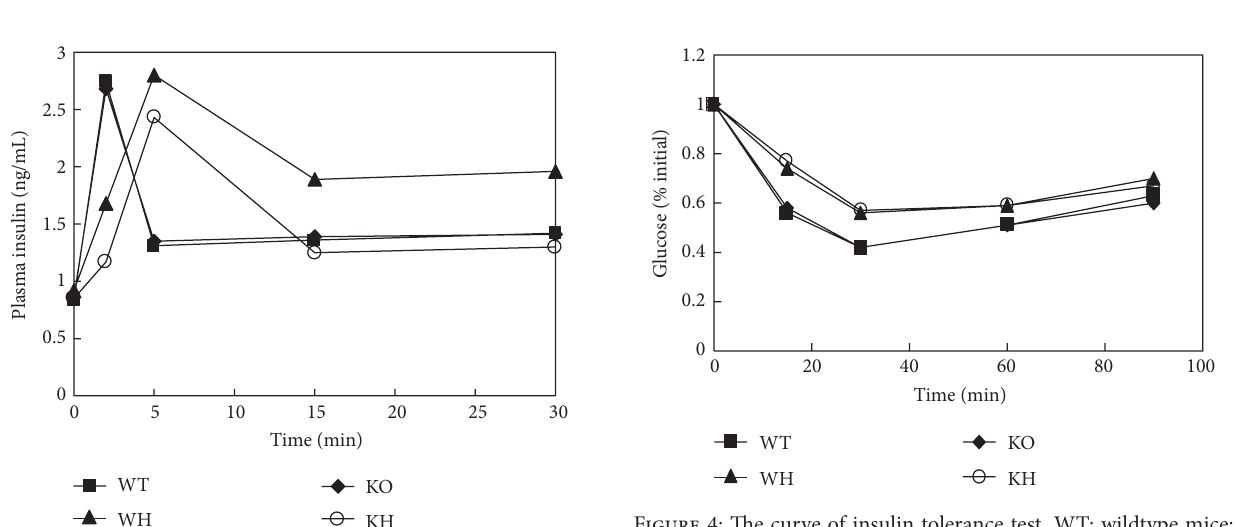
Figure 2: The curve of glucose tolerance test. (a) Glucose curve; (b) area under curve of glucose (AUCG). WT: wildtype mice; WH: wildtype mice with high-fat diet; KO: ACE2 knockout mice; KH: ACE2 KO mice with high-fat diet, versus WT ∗ 𝑃 < 0.05 , versus KO # 𝑃 < 0.05 , and versus WH 󳵻 𝑃 < 0.05 .